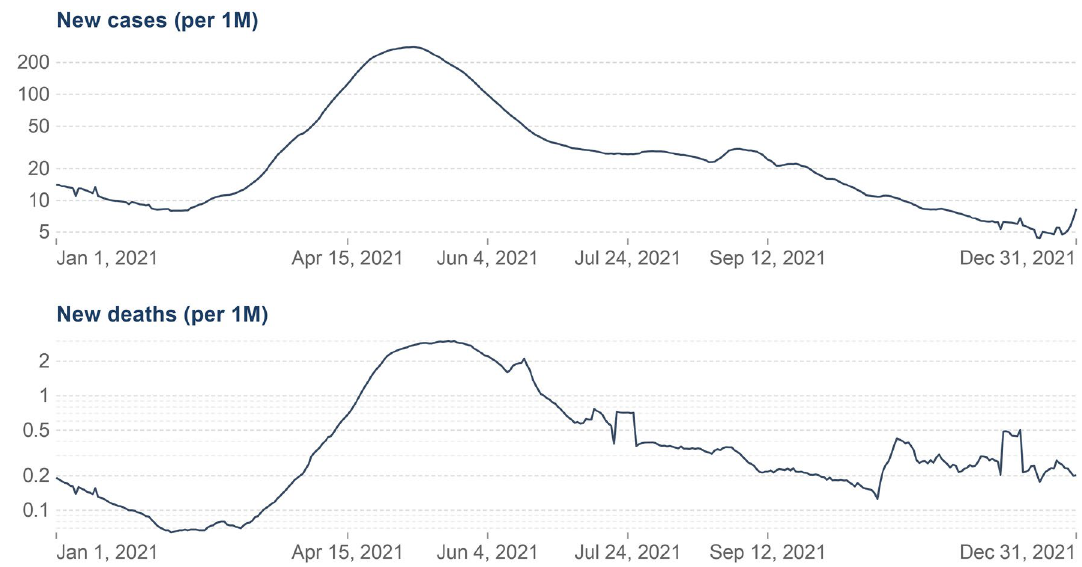
Figure 9. The ratio of new confirmed Covid-19 cases reported and death cases reported over the